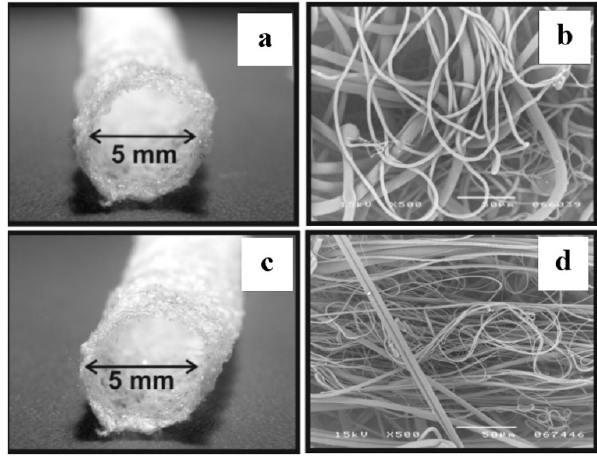
Figure 5. Tubular blood vessels fabricated by melt electrospinning: ( a , b ) polypropylene (Moplen 462R PP); ( c , d ) polylactide (PLA 4060D) (reprinted from Ref.